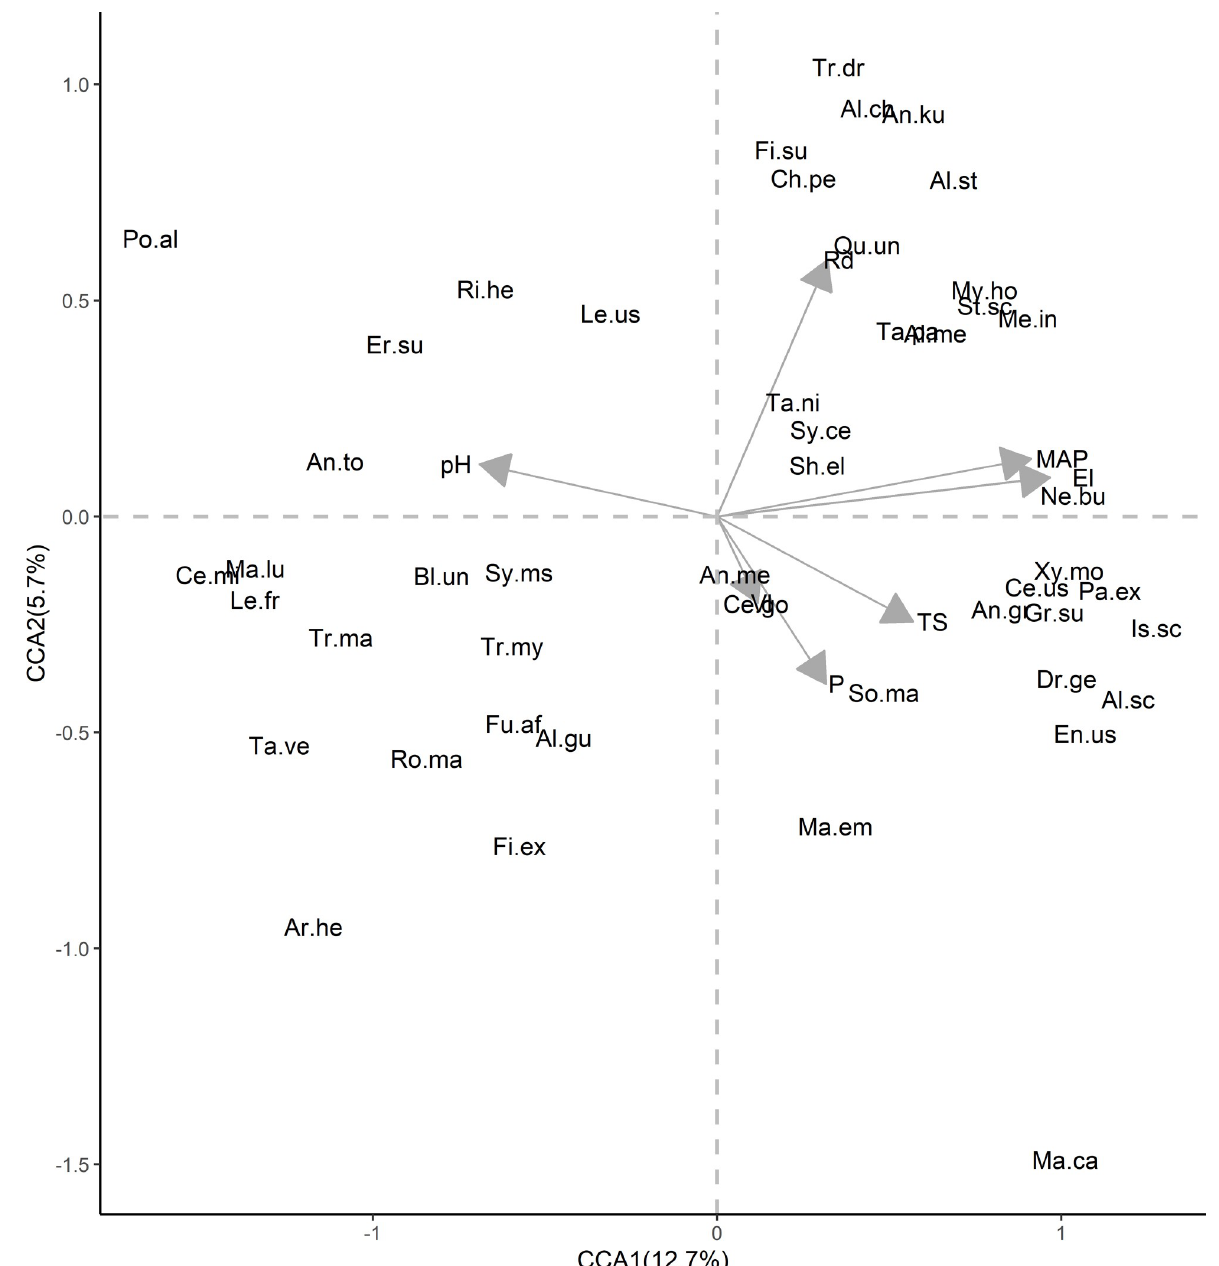
Fig 2. Canonical correspondence analysis diagram showing the ordination of dominant species represented and their correlation with environmental and disturbance variables in the sub-tropical montane forest plots. Canonical correspondence analysis biplot of Amani and Nilo FR species distribution (blue dots) based on tree species abundance. The gray axes vectors indicate the significant explanatory variables in their abbreviated form: El = Elevation, TS = Temperature seasonality, MAP = Mean Annual precipitation, P = Soil phosphorus, Rd = Distance to the road and Vl = Distance to the villages. We also used abbreviated species scientific names of each tree by using first two letters each from genus and species; Al . ch = Alangium chinense (Lour . ) Harms , Al . gu = Albizia gummifera (J . F . Gmel . )C . A . Sm ., Al . me = Allophylus melliodorus Gilg ex Radlk ., Al . st = Allanblackia stuhlmannii (Engl . ) Engl ., Al . sc = Alsodeiopsis schumannii (Engl . ) Engl ., An . ku = Annickia kummeriae (Engl . & Diels) Setten & Maas , An . gr = Anthocleista grandiflora Gilg , An . me = Antidesma membranaceum Müll . Arg . An . to = Antiaris toxicaria Lesch ., Ar . he = Artocarpus heterophyllus Lam , Bl . un = Blighia unijugata Baker , Ce . go = Celtis gomphophylla Baker , Ce . mi = Celtis mildbraedii Engl ., Ce . us = Cephalosphaera usambarensis (Warb . ) Warb ., Ch . pe = Chrysophyllum perpulchrum Mildbr . ex Hutch . & Dalziel , Dr . ge = Drypetes gerrardii Hutch ., En . us = Englerodendron usambarense Harms , Er . su = Erythrophleum suaveolens (Guill . & Perr . ) Brenan , Fi . ex = Ficus exasperata Vahl , Fi . su = Ficus sur Forssk ., Fu . af = Funtumia africana (Benth . ) Stapf , Gr . su = Greenwayodendron suaveolens (Engl . & Diels) Verdc ., Is . sc = Isoberlinia scheffleri (Harms) Greenway , Le . fr = Lecaniodiscus fraxinifolia Baker , Le . us = Leptonychia usambarensis K . Schum . Ma . ca = Macaranga capensis (Baill . ) Sim , Ma .